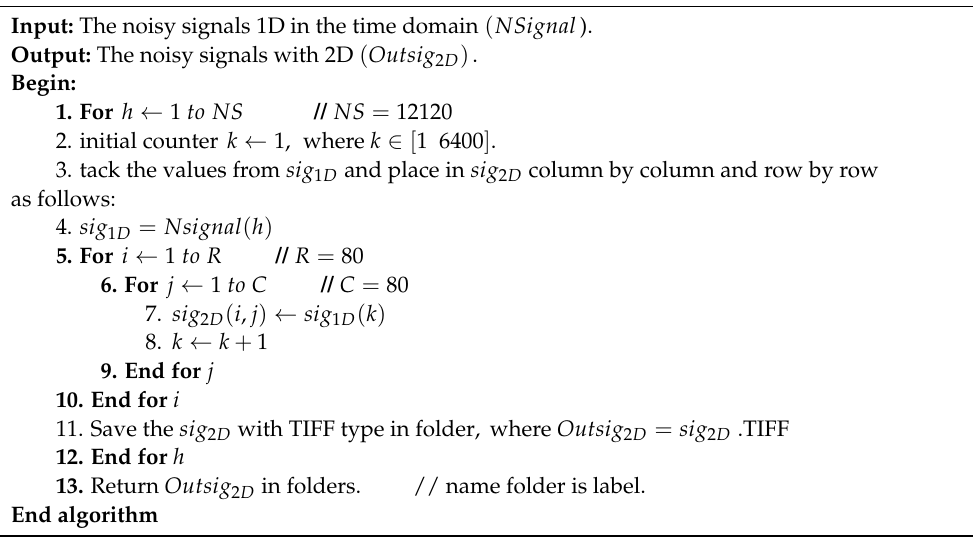
Algorithm 1: Converting 1D Signals into 2D